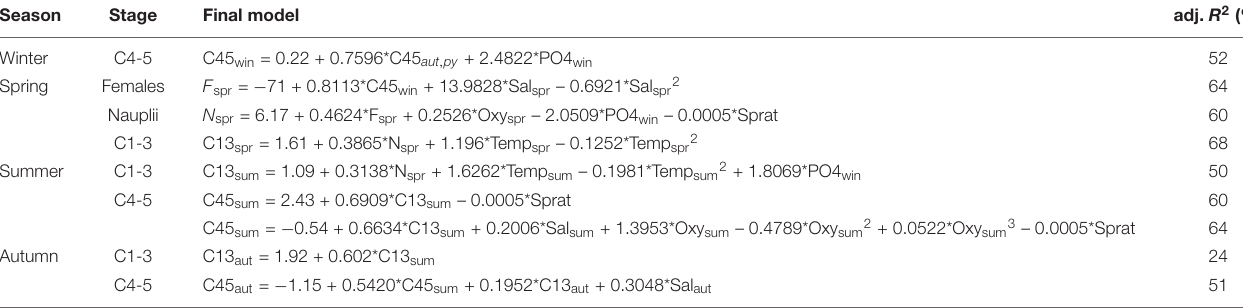
TABLE 2 | Overview of the final linear and polynomial regression models we selected for our simulations.